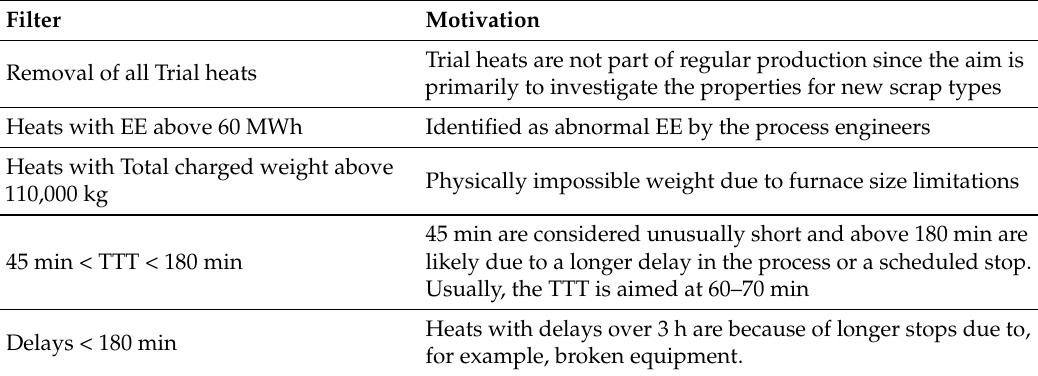
Table 6. The domain-specific cleaning rules that were applied to the data. The rules were applied to the training data and test data separately to simulate an applied data filtering system. Rules applied to the training data must be applied to the test data to safeguard against data points outside the scope of the statistical